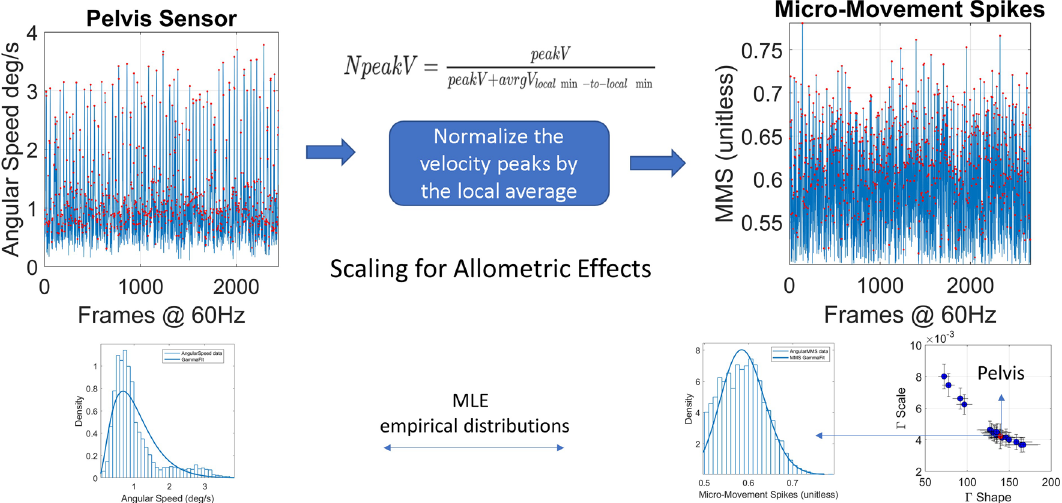
Figure 13. The MMS time series extraction from the angular speed tracking stochastic trajectories from all joints (red dot marks the pelvis for